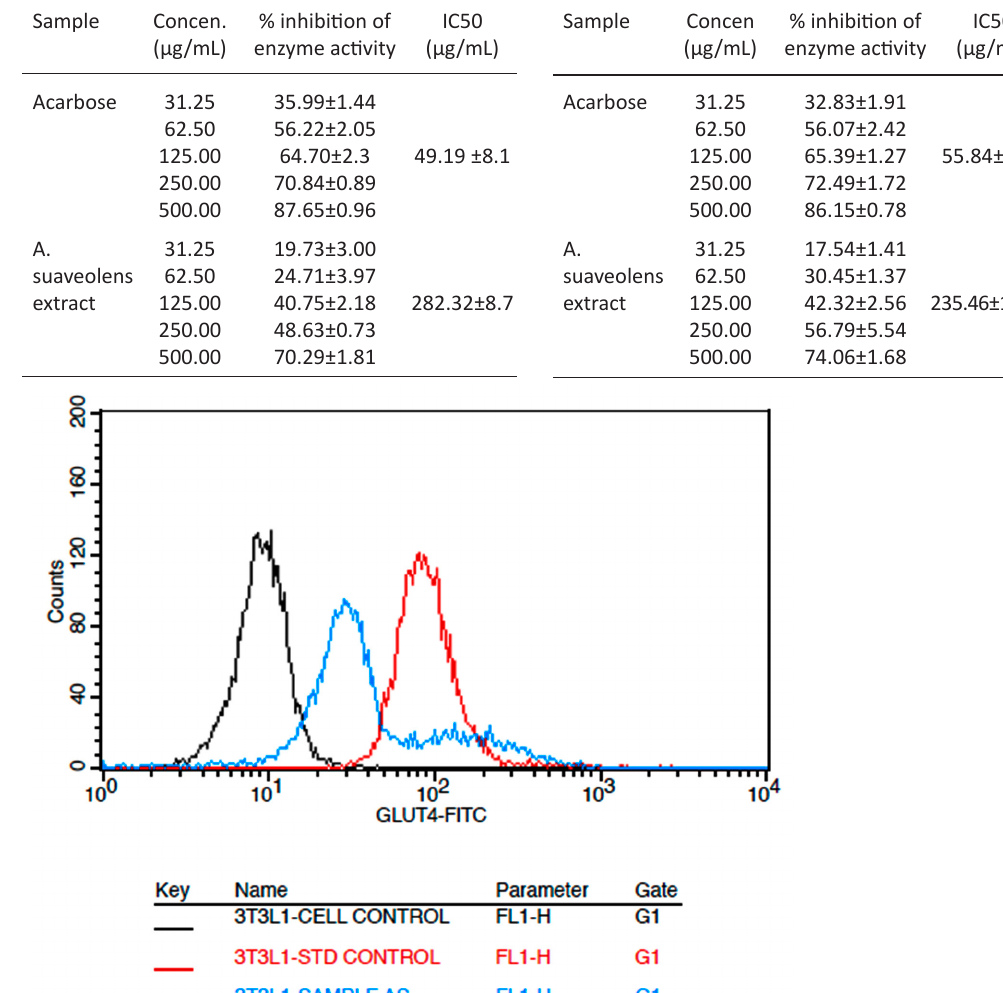
Fig. 6. Overlaid expression of GLUT4 in untreated 3T3L1 cells (black colour line) & standard drug treated cells (metformin 100um) (red colour line) and test compound treated cells (cyan colour line).